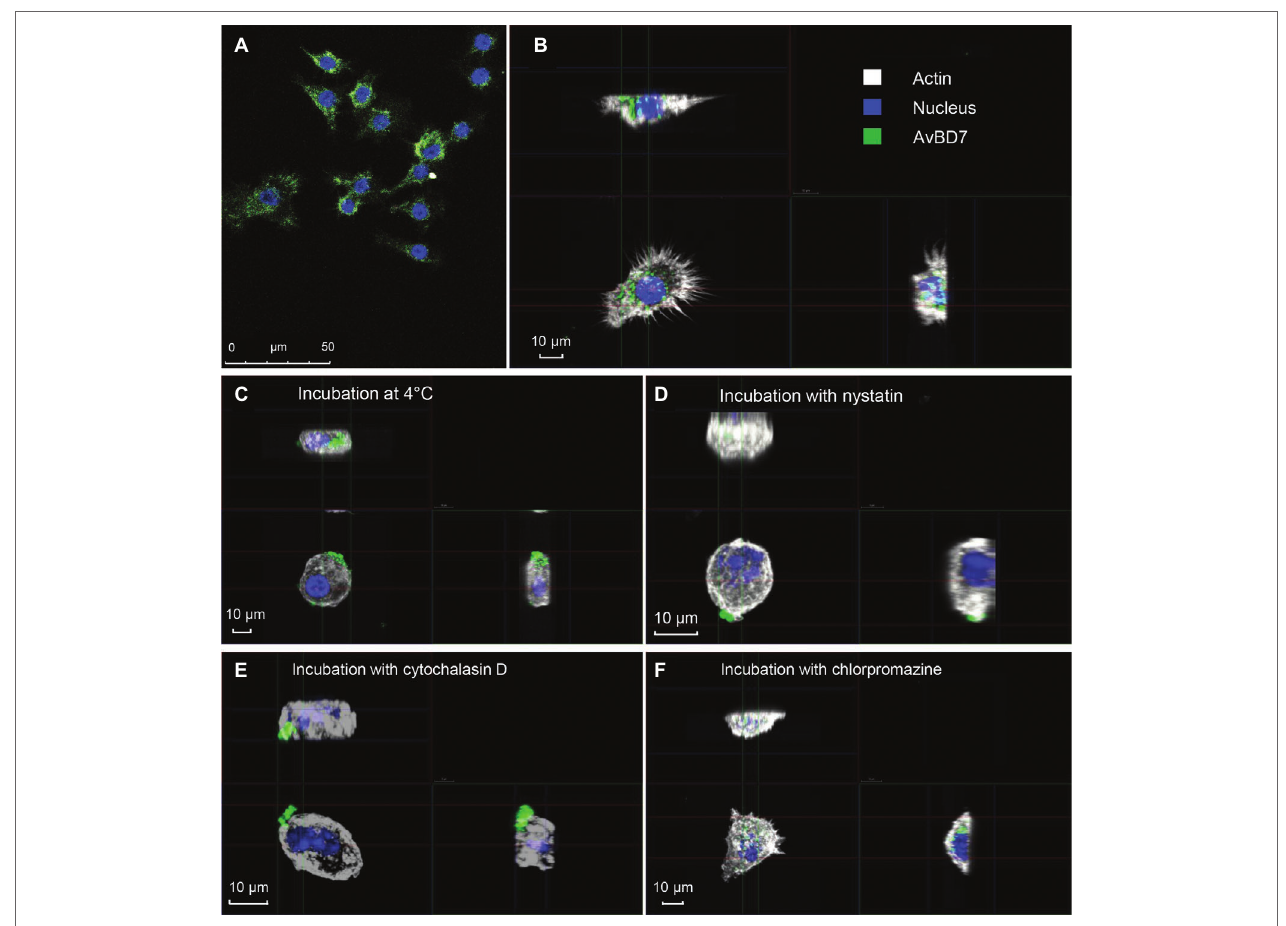
FIGURE 3 | Confocal microscopy imaging of AvBD7 interaction with mouse macrophages. RAW 264.7 macrophages were incubated with 3 μM of fluorescence- labelled AvBD7 (A) , and (B) , in the presence of cytochalasin D (C) or of nystatin (D) or of cytochalasin D (E) or of chlorpromazine (F) , and were fixed and processed for immunofluorescence. Nucleus is in blue, actin in white and fluorescence-labeled AvBD7 in green. Three dimension confocal microscopy images (B–F) shows horizontal (bottom left) and vertical (top left and bottom right) sections of a representative cell.